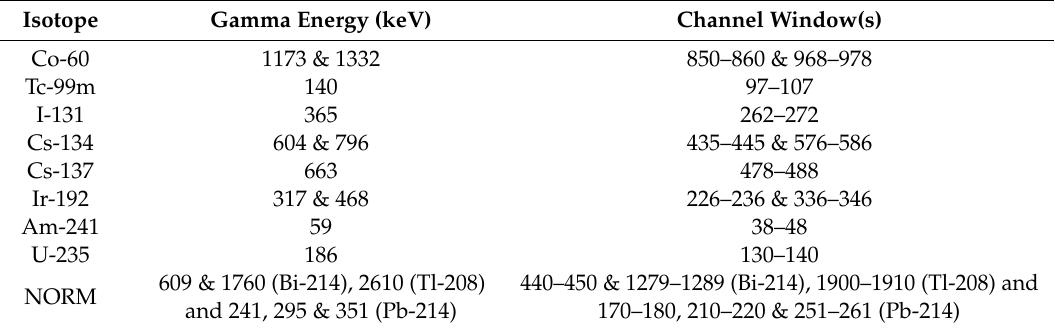
Table 2. Derived detection (channel) windows for the commonly occurring radionuclides listed in Table 1, for the Hamamatsu C12137-01 gamma-ray